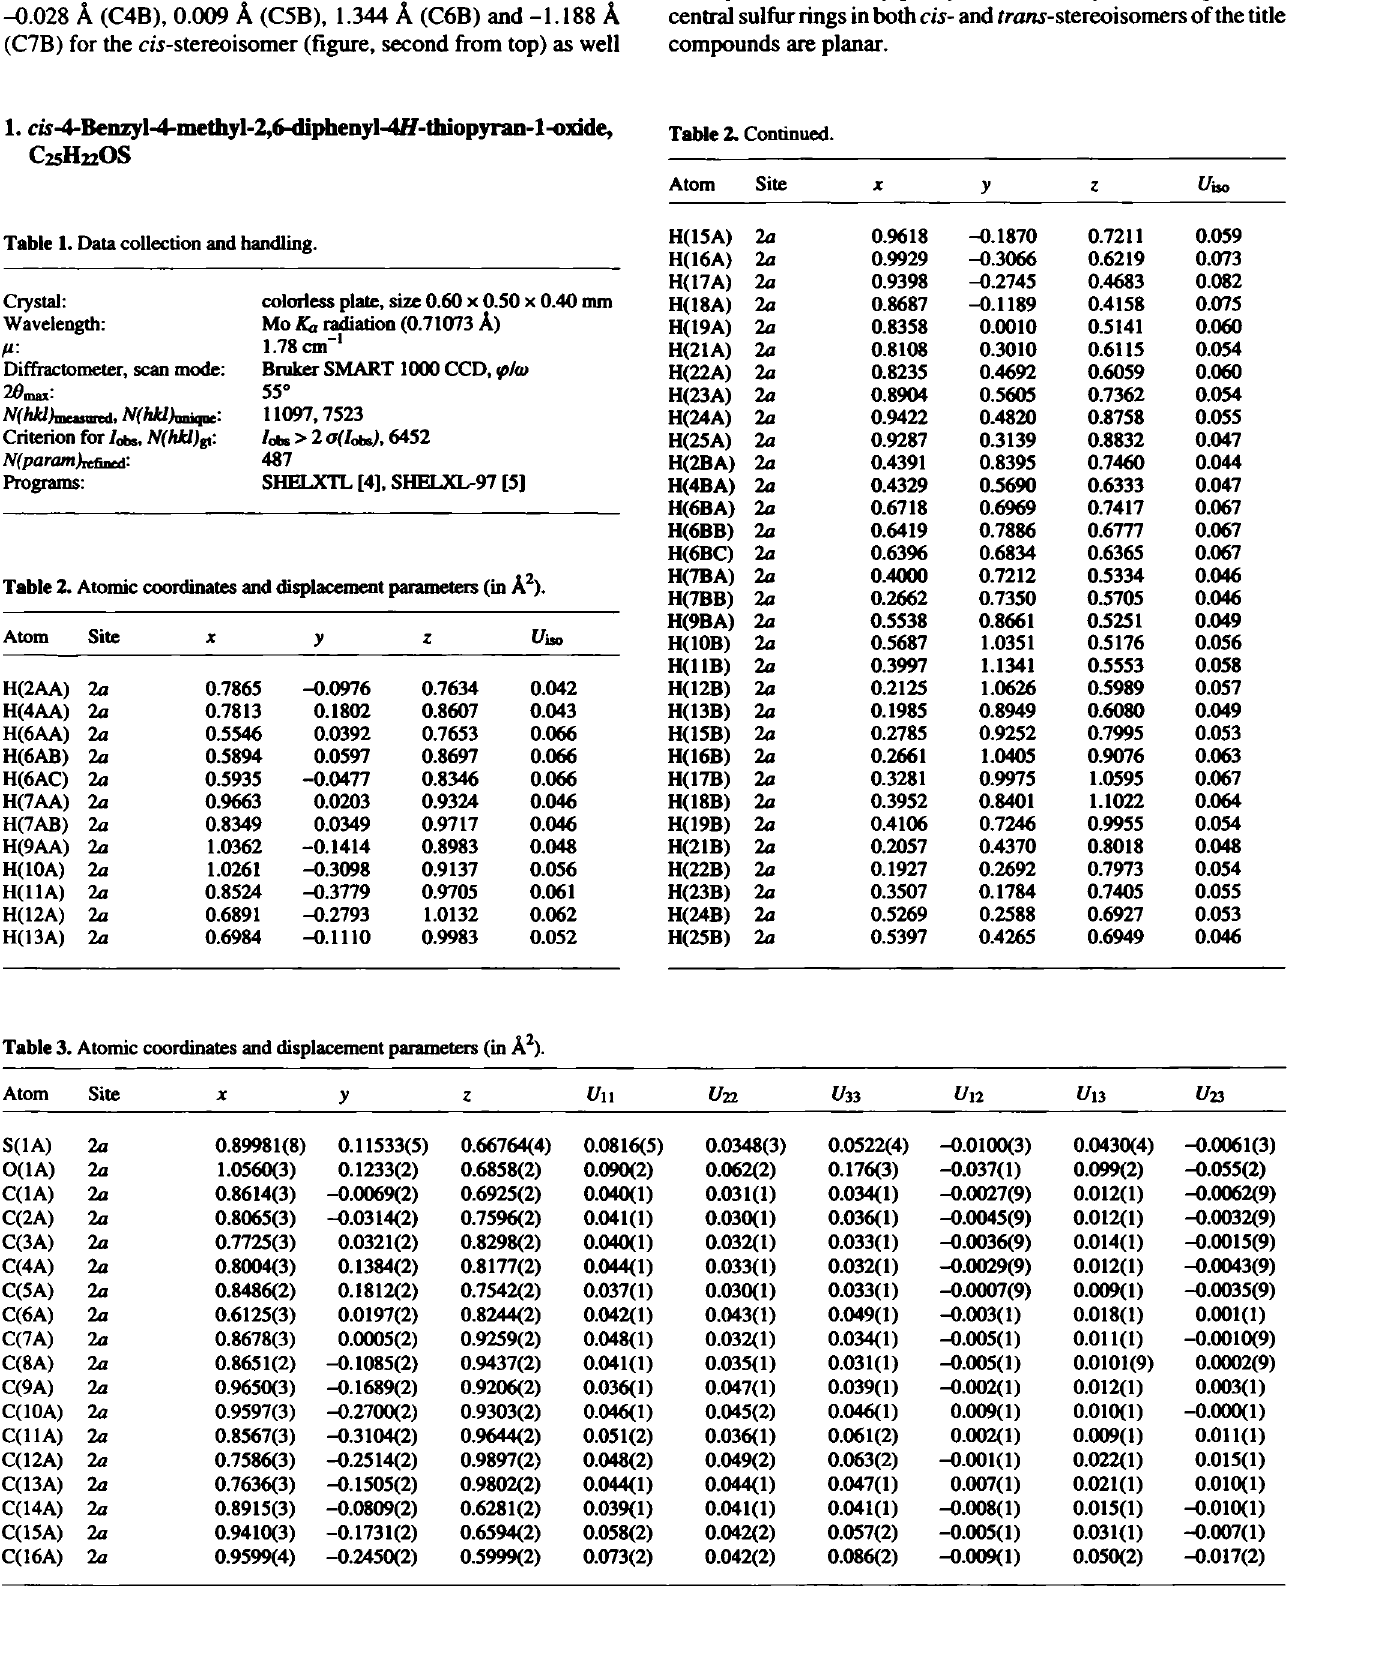
Table 1. Data collection and handling.